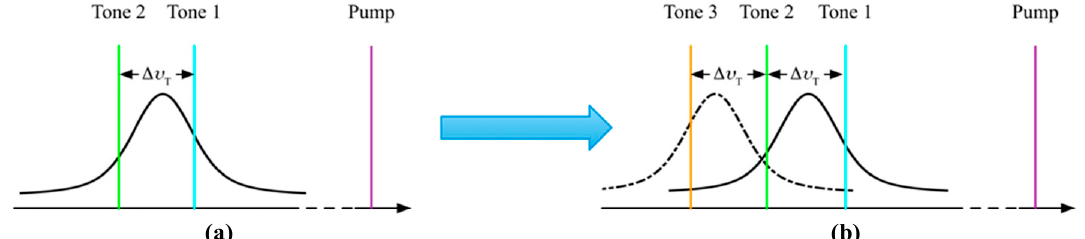
Figure 9. The frequency relationship [42] for ( a ) a double-slope-assisted scheme and ( b ) a multi-slope- assisted scheme.